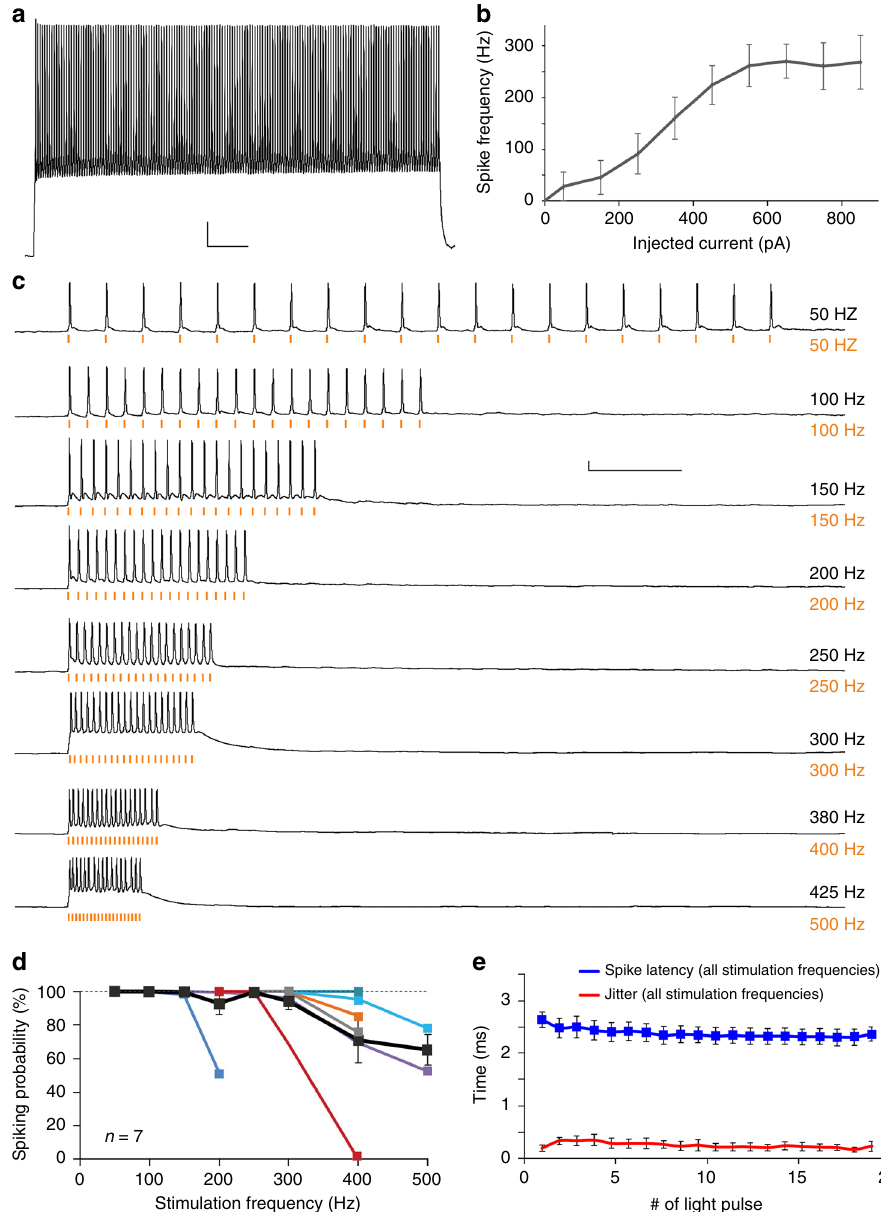
Fig. 3 vf-Chrimson drives fast interneurons to the frequency limit. a Example recording of a neocortical parvalbumin-positive interneuron in an acute brain slice. Current injection (500 ms, 550 pA) elicits high frequency fi ring (322 Hz), consistent with the fast spiking phenotype of these interneurons. b When tested with constant current injection, the input – output curve of PV-interneurons plateaus at a maximum fi ring rate of 270± 33 Hz ( n = 8). c Example traces of the vf Chrimson-expressing PV-interneuron from a activated by light pulses (565 nm, 0.5 ms) at frequencies ranging from 50 – 500 Hz. Note that this interneuron reliably followed frequencies of up to 400 Hz. d Spiking probabilities of PV-interneurons at different optical stimulation frequencies. On average (black), PV-interneurons followed stimulation up to 300 Hz reliably (94 ± 5% spiking probability), and could still encode input frequencies of up to 400 Hz with a reliability of 68 ± 16% ( n = 7; three whole-cell, four cell-attached recordings). e Action potential latency (assessed at peak) and action potential jitter (s.d. of latencies) after light pulse onset for all stimulation frequencies with reliable spiking (>85%). Error bars are s.e.m. Scale bars: a 50 ms, 10 mV c 50 ms, 10 Fig. 10f, i) as compared to 80 µs in young mice (Fig. 5e). Moreover, we were able to record oABRs at stimulation frequencies as high as 250 Hz (11 mW, 1 ms pulse duration), likely due to the lower average latencies found in these aged mice Fig. 10g, j). Together the data indicate that optical activation of